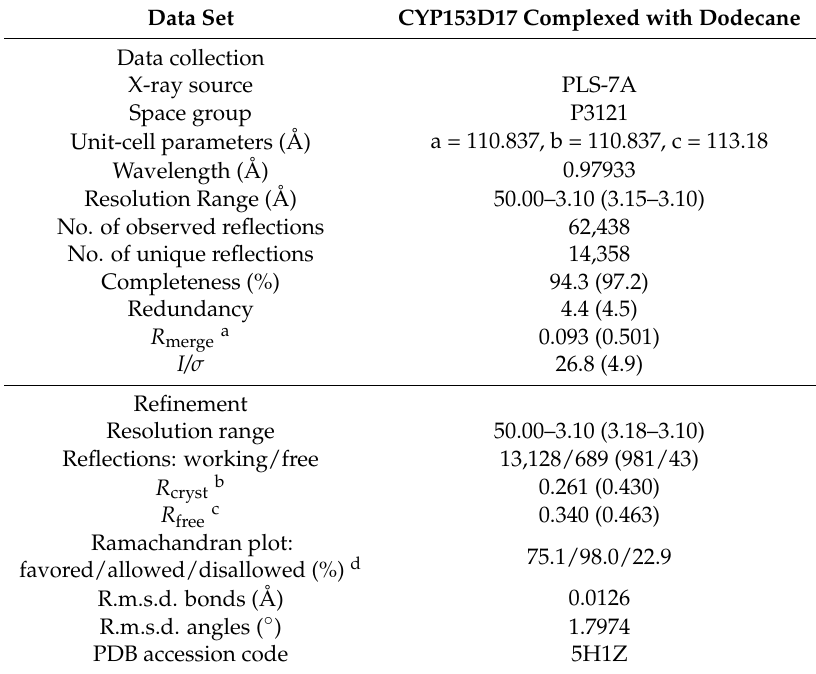
Table 2. X-ray data collection and refinement statistics.